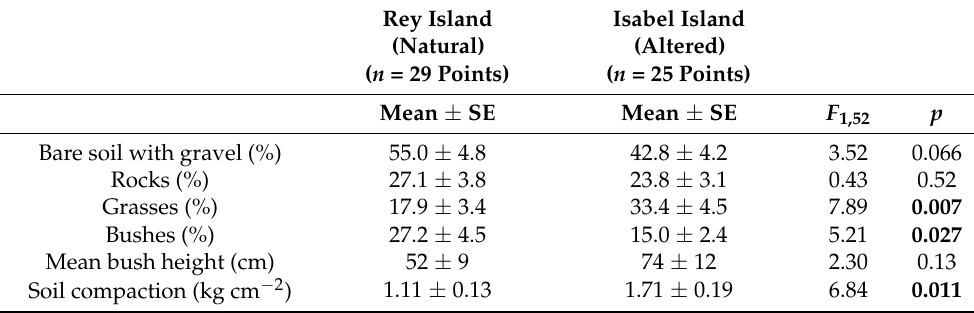
Table 1. Characteristics of microhabitats (mean ± SE) at two of the Chafarinas Islands with different levels of anthropogenic disturbance (natural: Rey; altered: Isabel) based on 54 random habitat samples. The statistics ( F and p ) are given from one-way ANOVAs tests comparing both islands. Significant comparisons are marked in bold. Rey